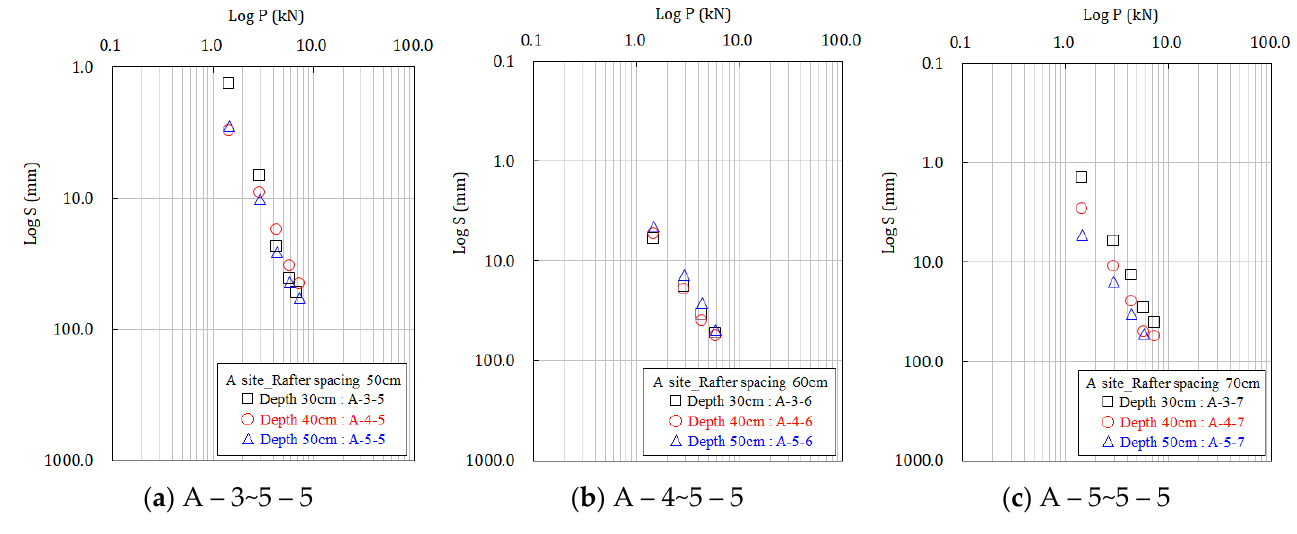
Figure 9. Results of field uplift resistance on site A.